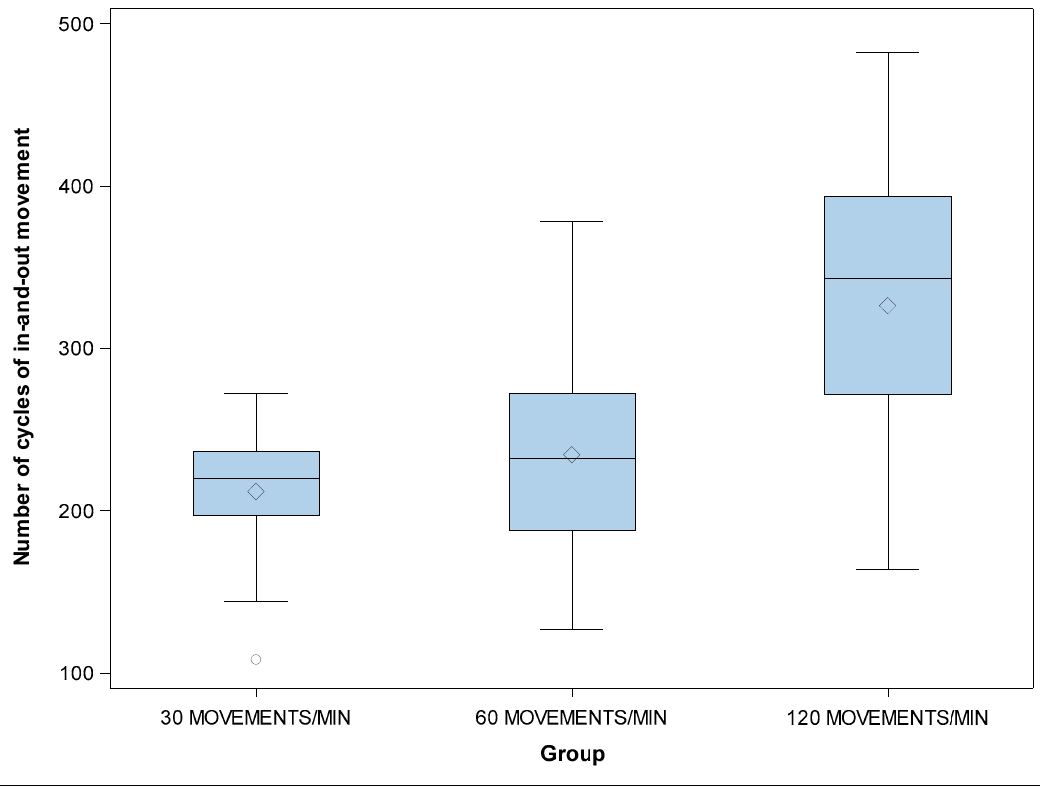
Figure 8. Boxplots of the number of cycles of in-and-out movement of the experimental groups. The horizontal line in each box represents the median